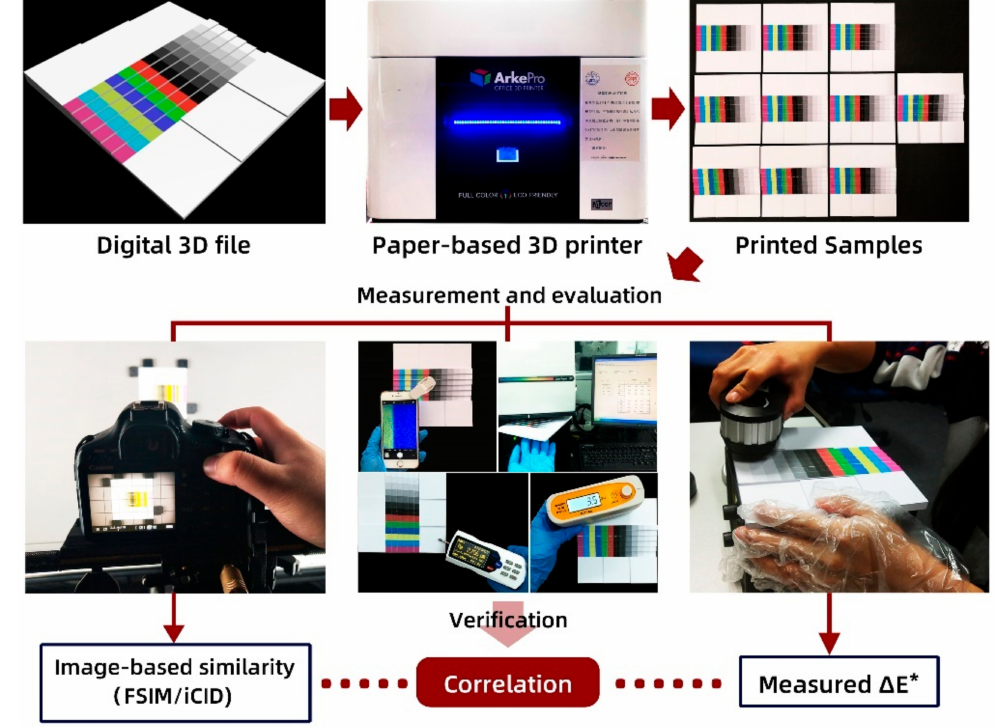
Figure 1. The flowchart of our